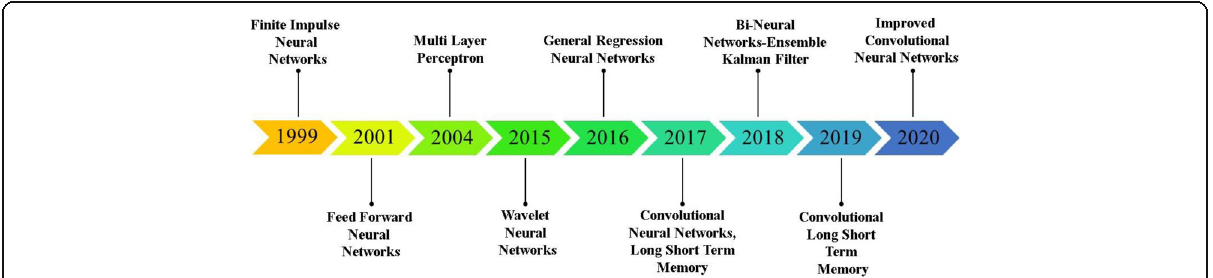
Fig. 6 Timeline of application of the various ANN-based models for SST